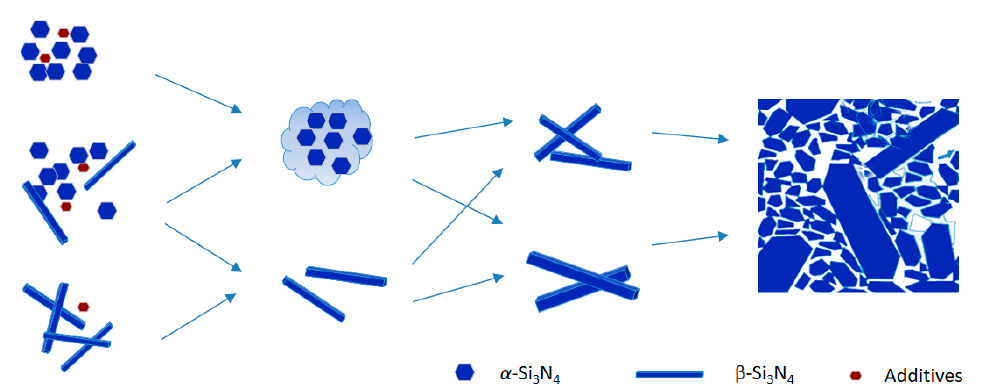
Figure 2. The schematic representation of Si 3 N 4 crystal phase transition.